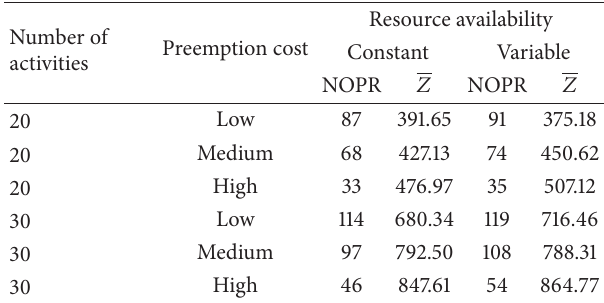
Table 3: Computational results of the LINGO and SA.